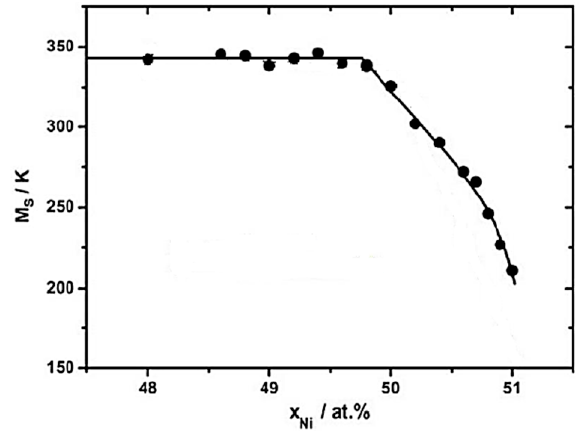
Figure 7. Influence of nickel content on martensite start temperature [75].